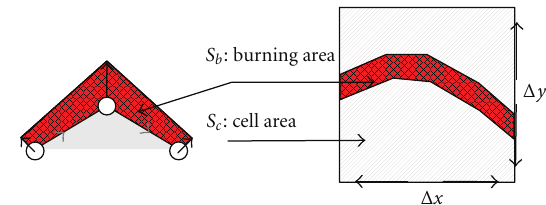
Figure 2: Integration of burning area. Red shape represents the fire front. Integration is performed on each atmospheric cell to compute the ratio of the burning area over the cell